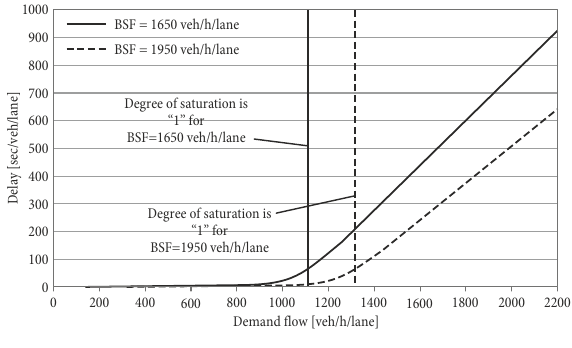
Fig. 9. Delay plots for 1650 veh/h/lane and 1950 veh/h/lane BSF values